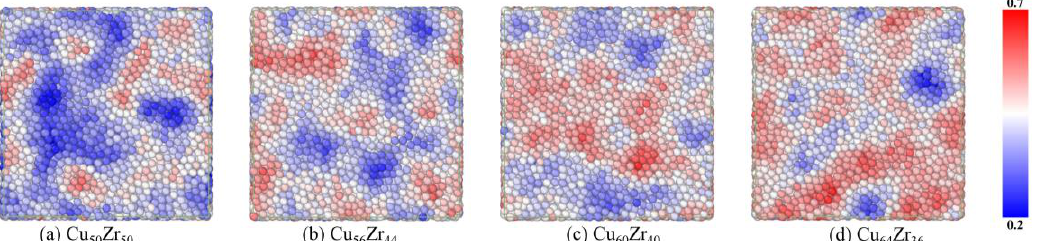
Figure 6. The evolution of the ratio of dominant polyhedra ratio ( 𝐹𝑛 ) of different component specimens, with the color red representing the region with high dominant polyhedra content and the color blue representing the region with low dominant polyhedra content. ( a ) Cu 50 Zr 50 , ( b ) Cu 56 Zr 44 , ( c ) Cu 60 Zr 40 , ( d ) Cu 64 Zr 36 .